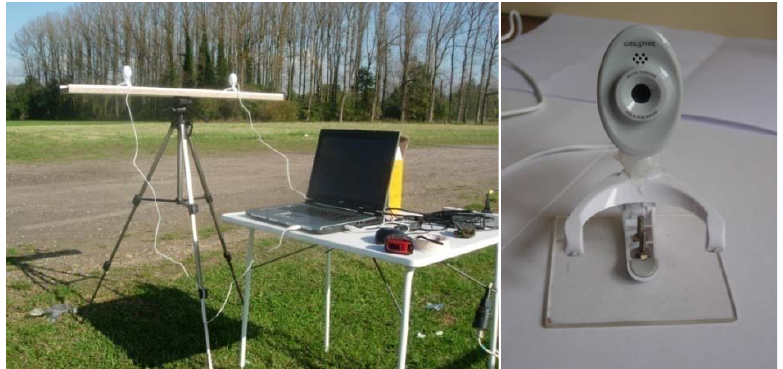
Figure 1. Illustration of the positioning of the webcams for stereo recordings. Left, two Creative webcams. Right, a detail on a Creative webcam mounted on a plate.